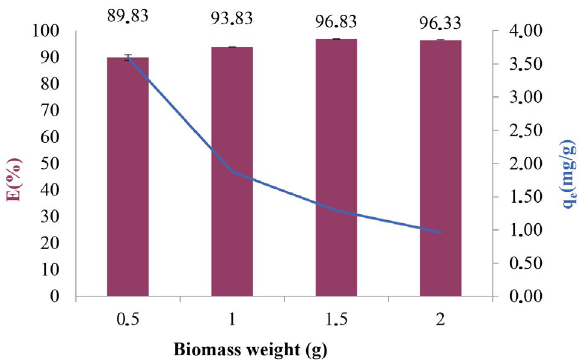
Figure 4. Effect of the initial biomass weight, standard deviations calculated from measurements from nine parallel results, where E-efficiency of adsorption, q e -maximum adsorption capacities at equilibrium (C i = 20 mg/L, 160 µm, 700 rpm, pH = 6.0 ± 0.2, T = 20 ± 1 °C).